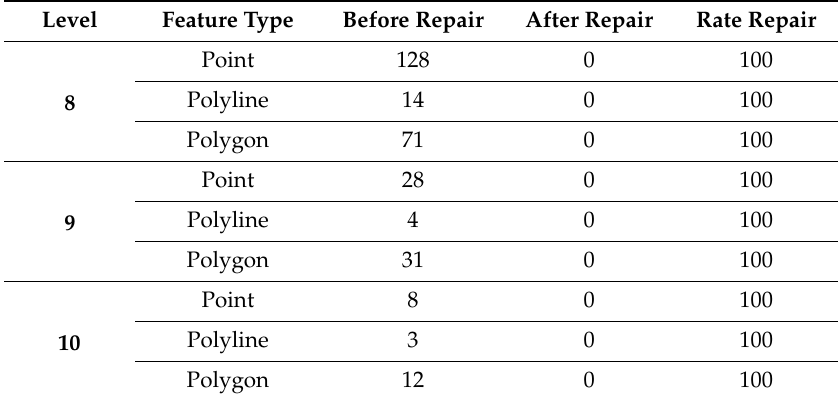
Table 2. Number of topological distortions before and after repair and repair rate.